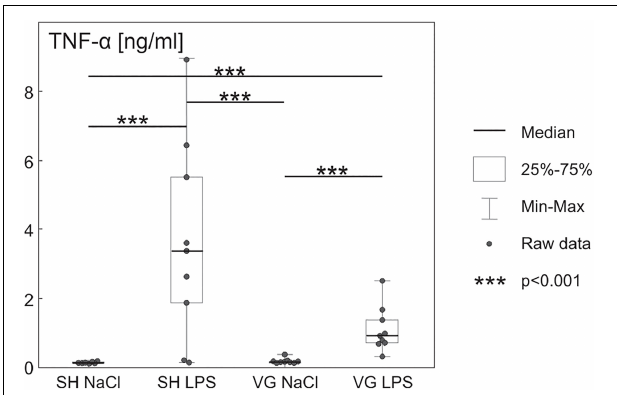
FIGURE 1 | Increased plasma tumor necrosis factor α (TNF- α ) concentration after intraperitoneal injection of LPS confirm initiation of pro-inflammatory activity of the immune system. Details in